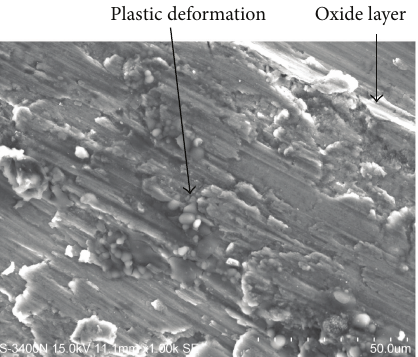
Figure 15: SEM analysis of worn surface of Al + 6% graphite; load- 50